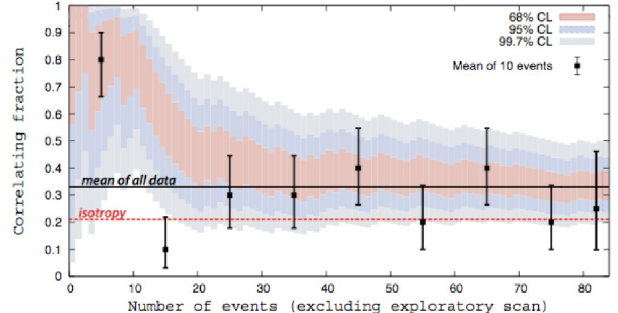
Figure 6: The correlating fraction as a function of the total number of time-ordered events. Different con- fidence levels are shown, together with the isotropy value p=0.21 and the current estimate of all data, p data = 0 . 33 ± 0 .